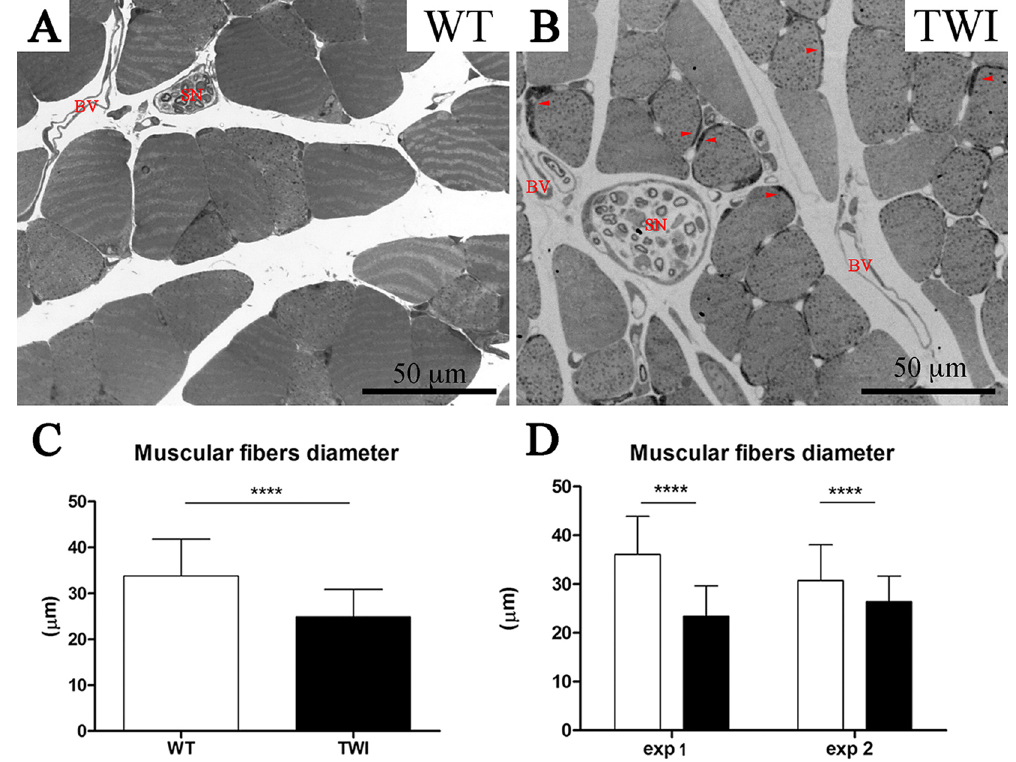
Figure 6. P30 gastrocnemius muscle fibers diameter. ( A,B ) Optical microscopy images showing the cross- sectional area of myofibers in gastrocnemius muscle of WT versus TWI mice. Arrowheads indicate higher mitochondria accumulation; SN indicate sciatic nerves and BV blood vessel. ( C ) Evaluation of mean values of myofibers diameter in WT and TWI mice. ( D ) Evaluation of fibers diameter in different mice show the same trend of